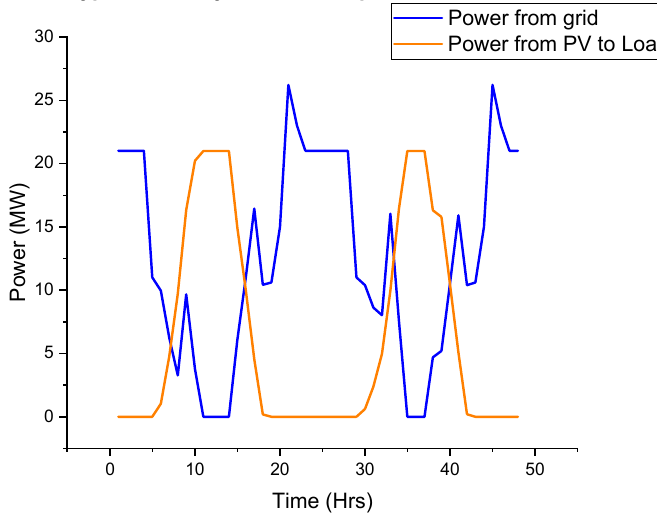
Figure 12. Two typical consecutive days with good PV production.